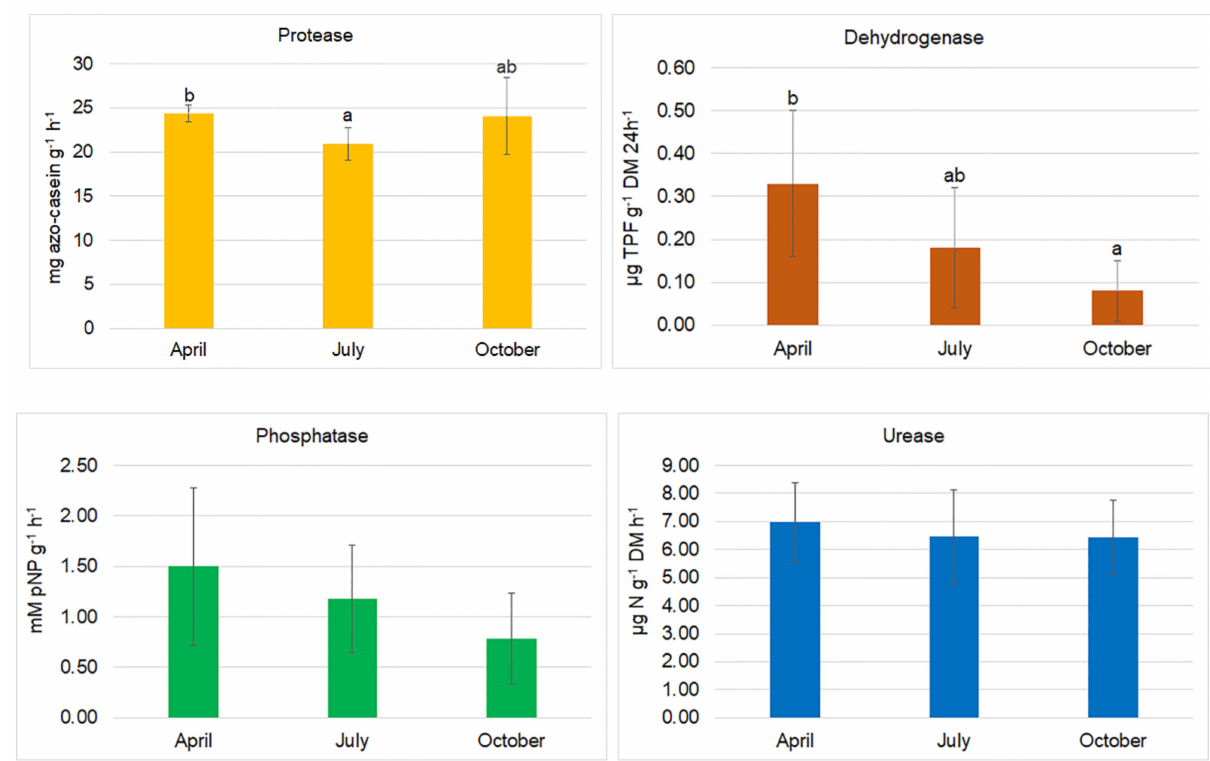
Figure 2. Seasonal changes of enzyme activities. Different letters above bars (mean ± standard deviation ) indicate significant difference (P < 0.05).